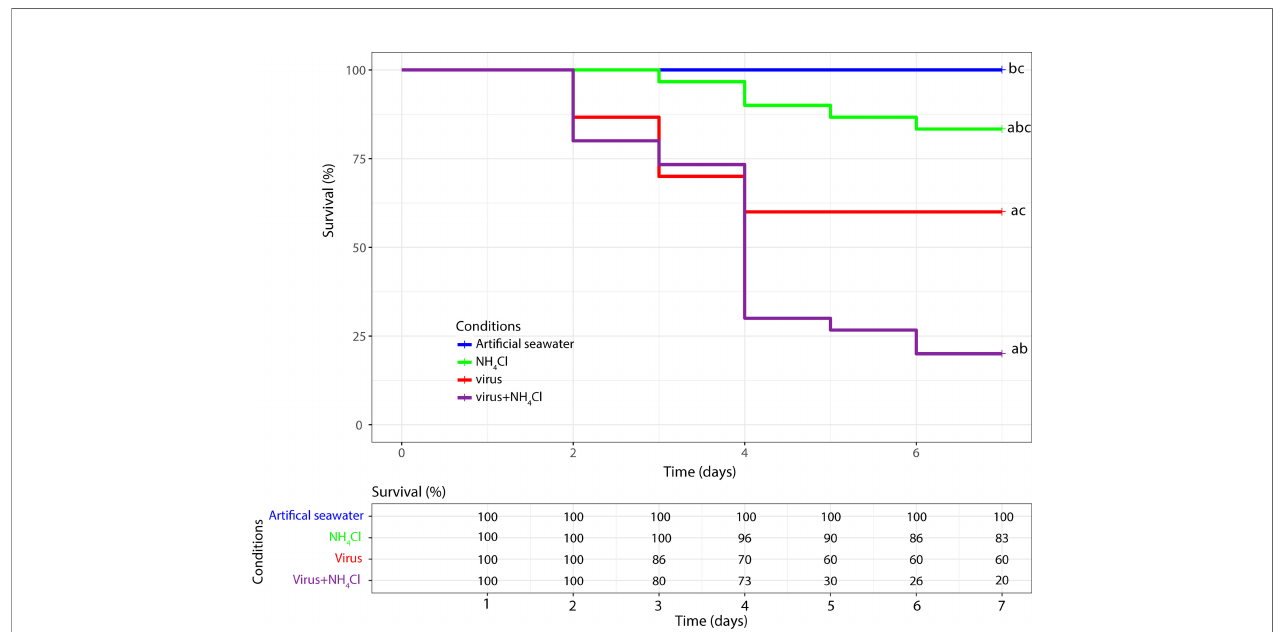
FIGURE 1 | Kaplan-Meier survival curves of the paci fi c oyster Crassostrea gigas injected with the virus OsHV-1, exposed to NH 4 Cl or injected with OsHV-1 and exposed to NH 4 Cl. The control condition corresponds to paci fi c oysters injected with arti fi cial sea water. In each condition the mortality was monitored on n=30 oysters. a: signi fi cant difference with the arti fi cial seawater condition (p < 0.05). b: signi fi cant difference with the virus condition (p < 0.05). c: signi fi cant difference with the virus+NH 4 Cl condition (p <